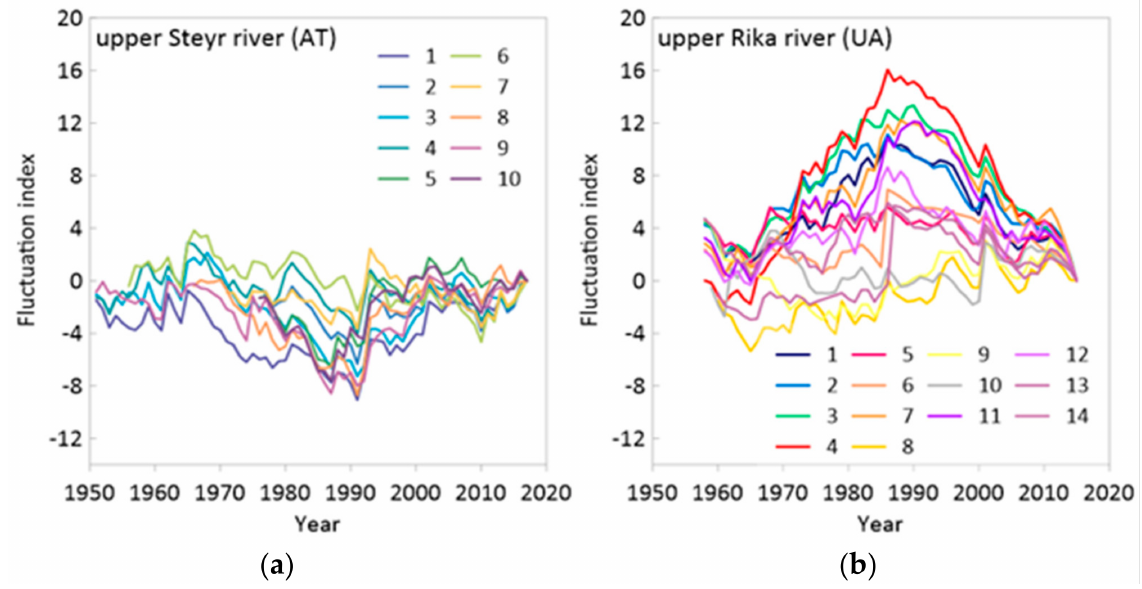
Figure 4. Fluctuations of maximum winter floods in the upper Steyr ( a ) and upper Rika catchments ( b ). Labels of symbols refer to ID number in Table 1 (upper Rika) and Table 2 (up- per